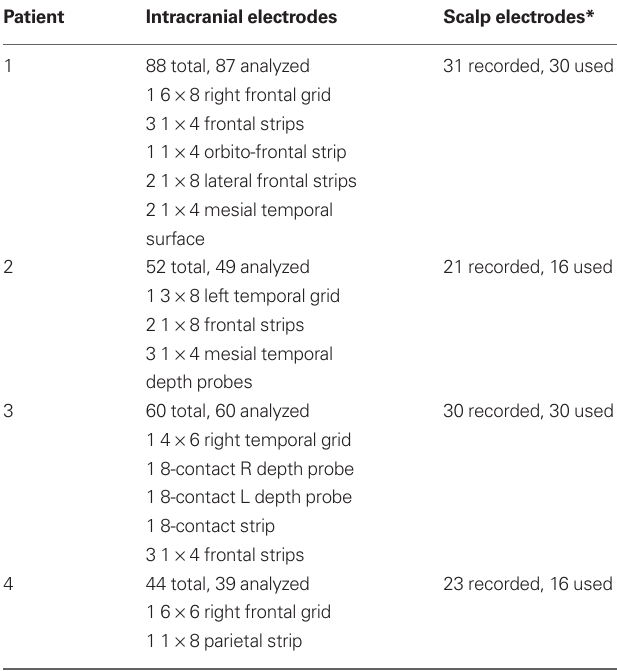
Table 1 | Numbers and locations of